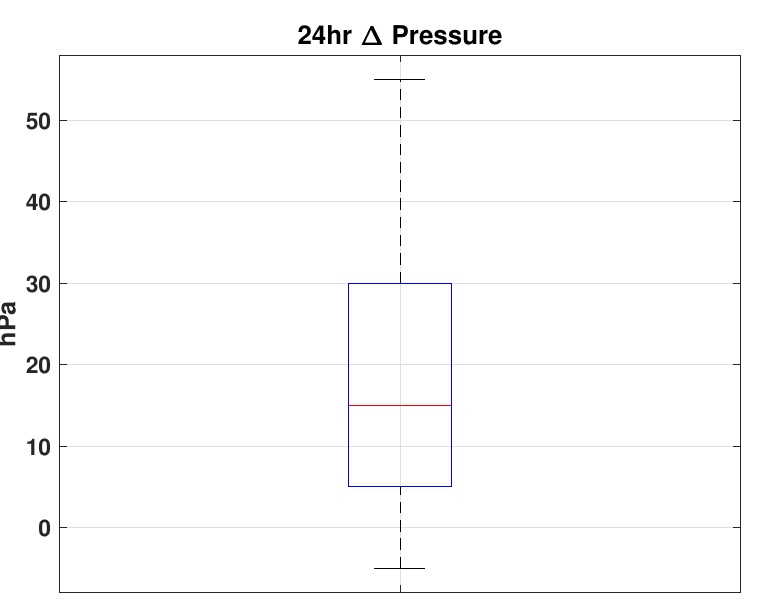
Figure 2. The box-whisker plot of increase in the central pressure of TCs in 24 h after passing 30° N. The box covers lower and upper quartiles and the whiskers are extended to the minimum and maximum